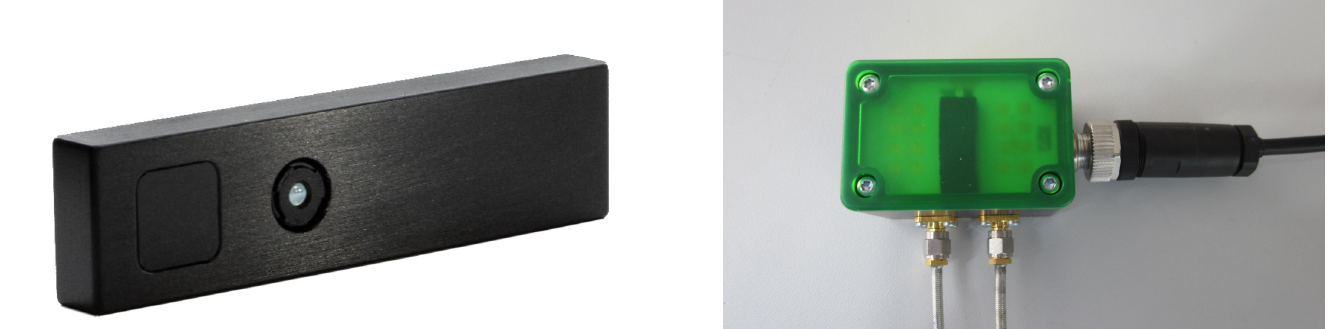
Figure 4. Pico flexx 3D time-of-flight camera by pmd [62] ( left ) and radar sensor by InnoSenT ( right